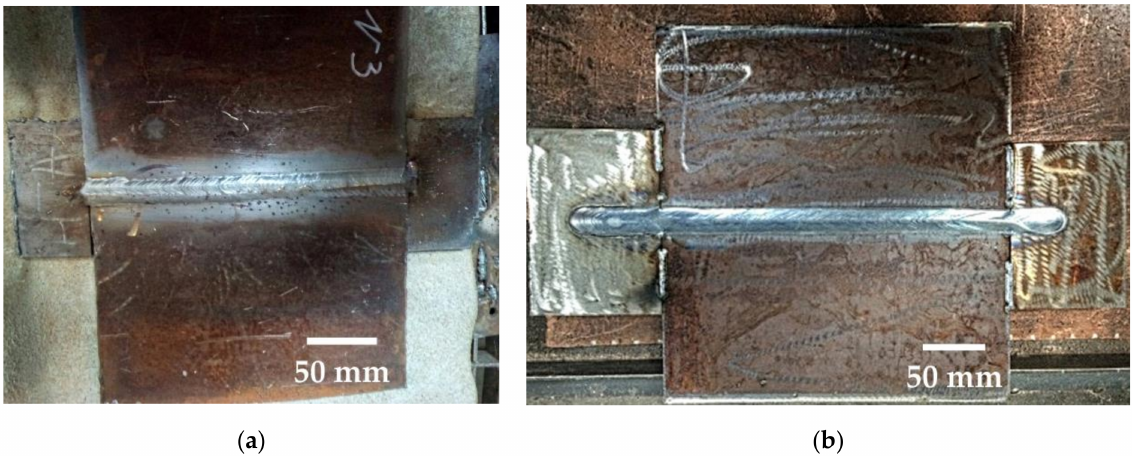
Figure 3. The appearance of welds: ( a ) from 10HSND steel; ( b ) from 09G2S